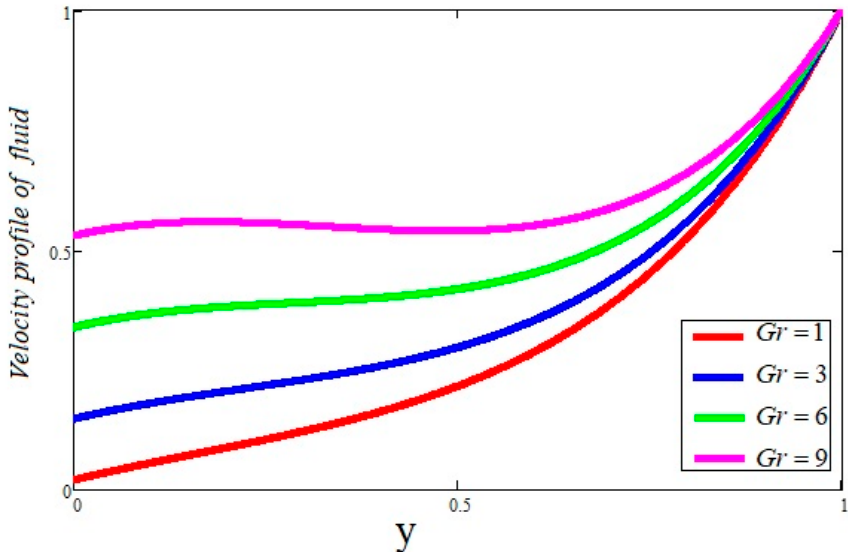
Figure 2. Impact of G r on the profile of fluid velocity.